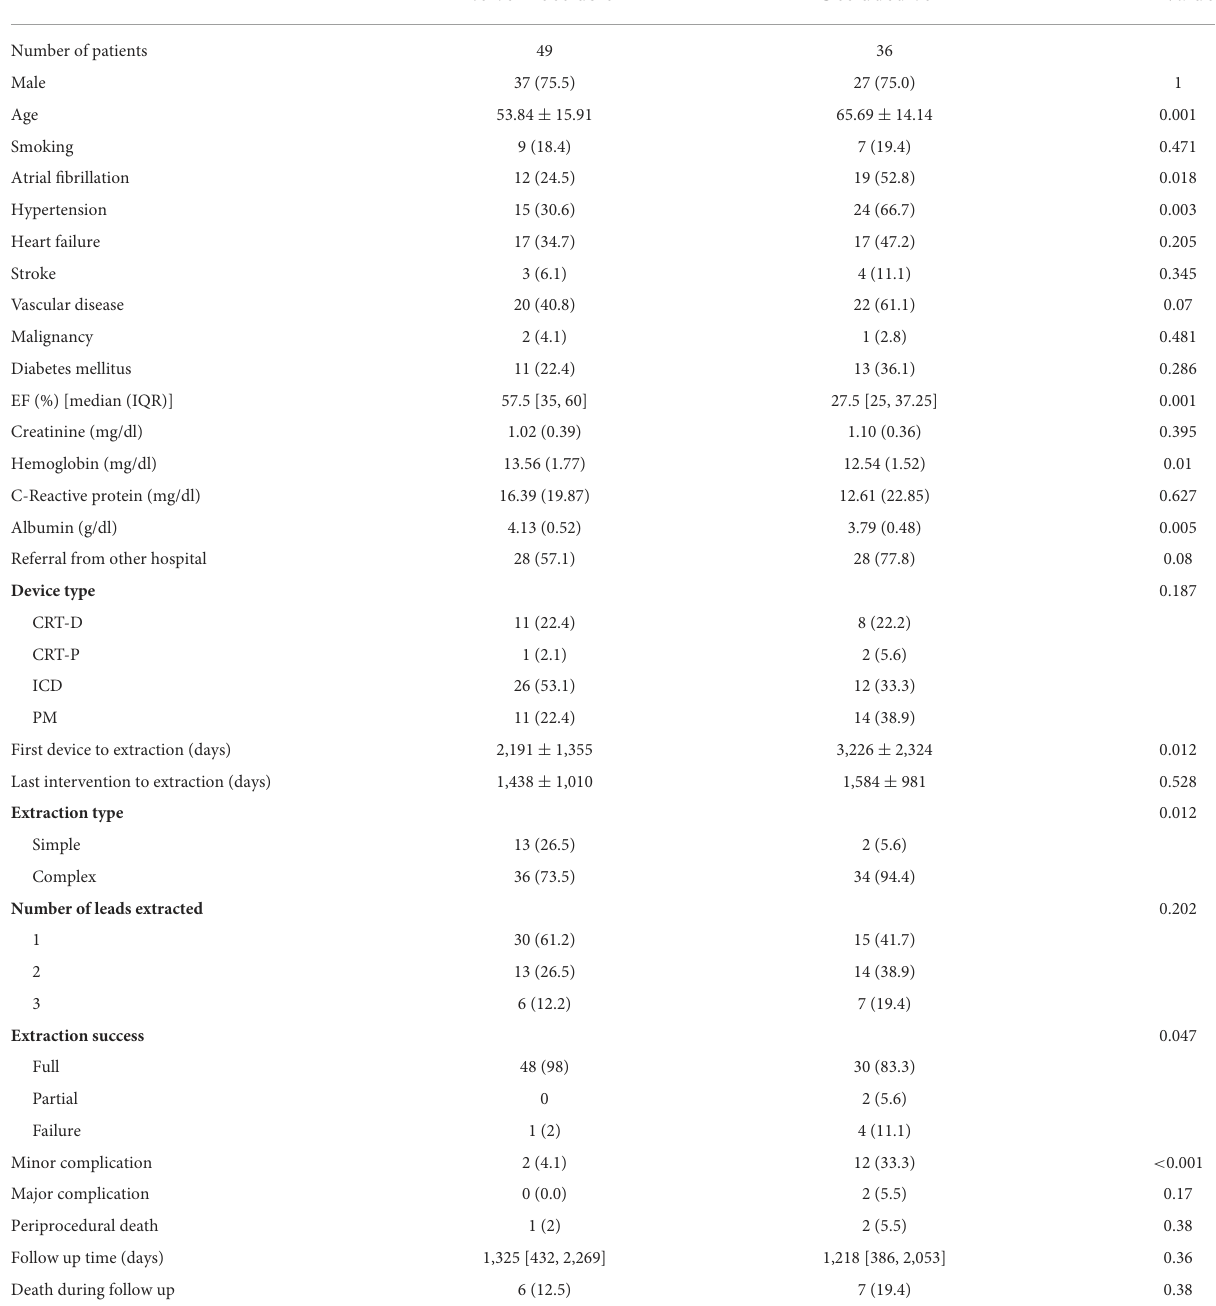
TABLE 3 Comparison according to occluded vein presence. No vein occlusion Occluded vein P -Value Number of patients